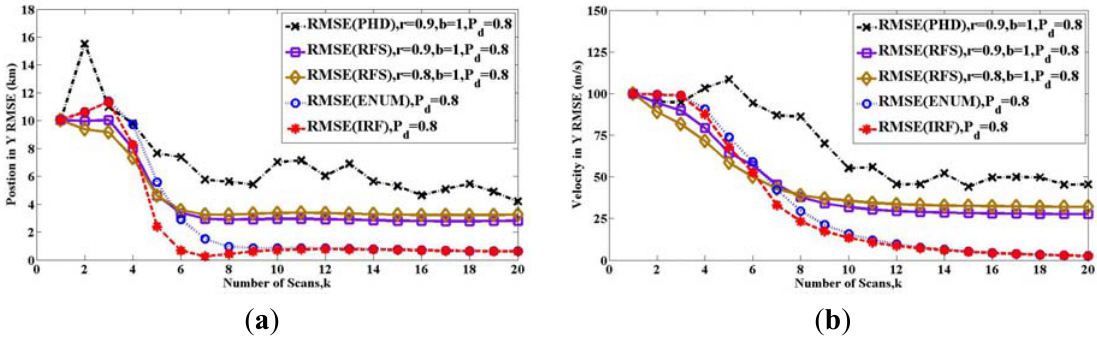
Figure 7. Comparisons of the performance of PHD filter and the bounds with different maintenance probability r: ( a ) Position in Y axes ( b ) Velocity in Y